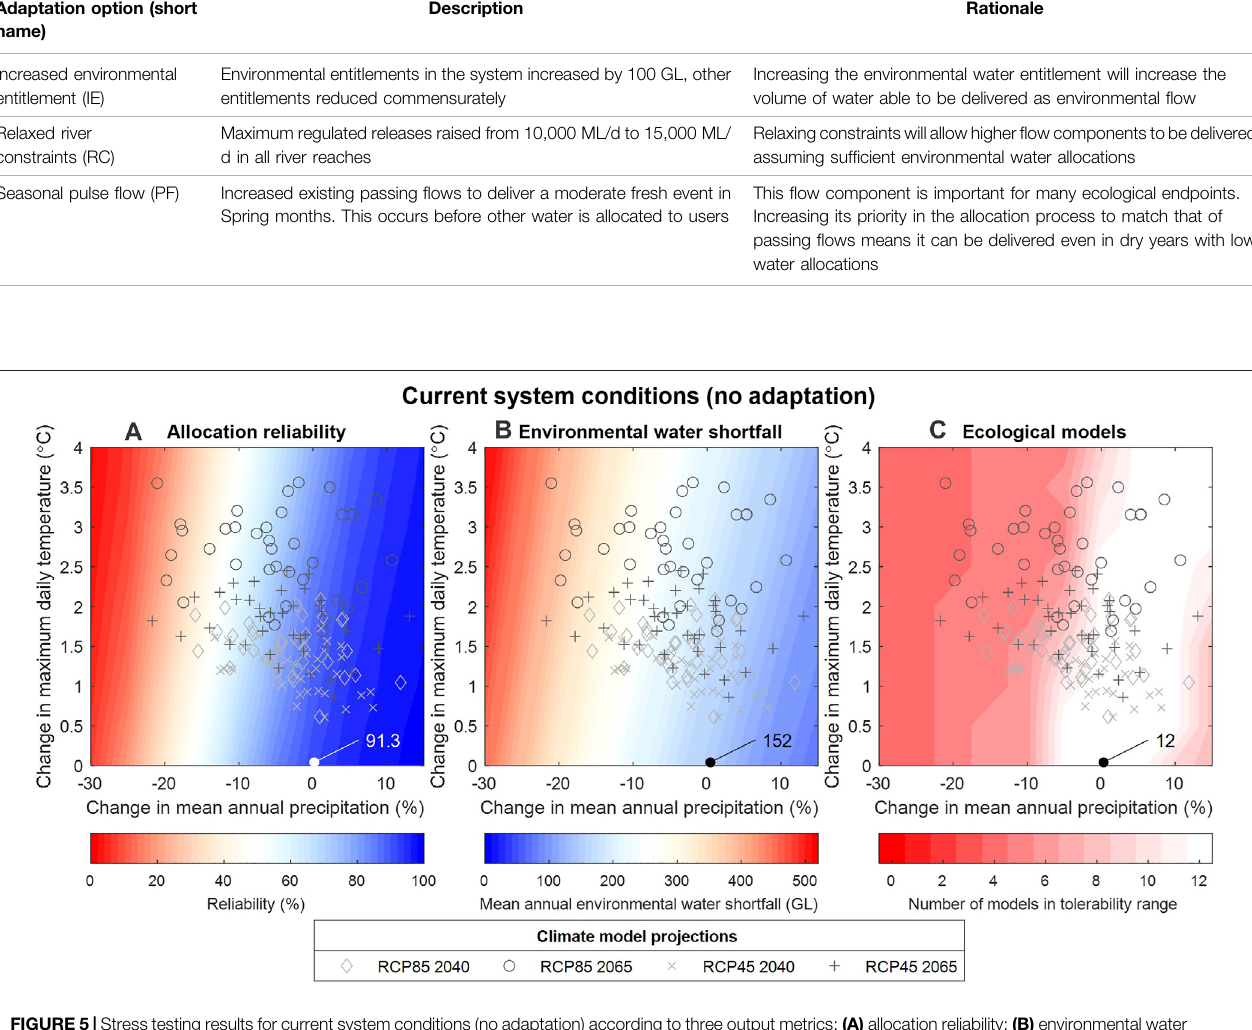
Frontiers in Environmental Science |